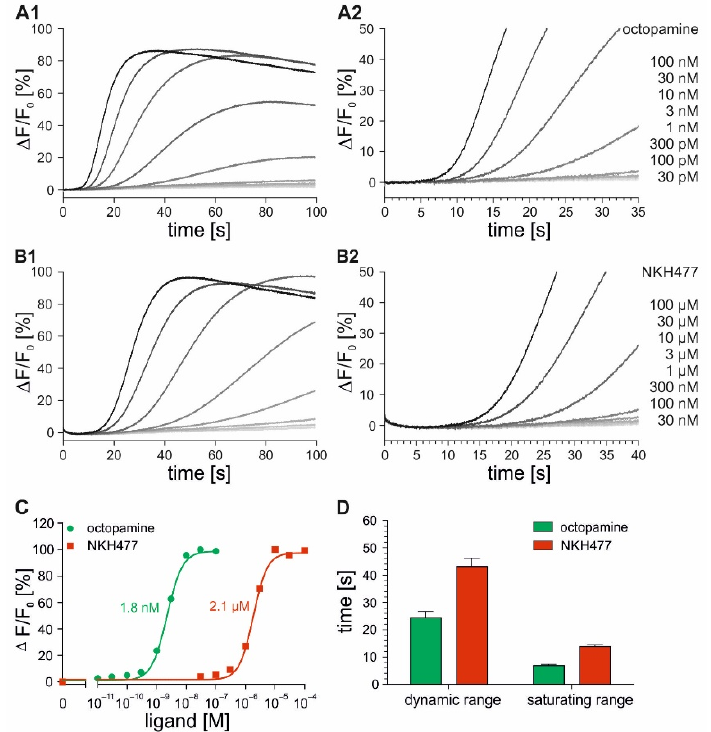
Figure 5. Stopped-flow experiments with FlpTM-DmOct β 1-GCaMP3.0 cell lines. FlpTM-DmOct β 1-GCaMP3.0 cells were stimulated with increasing octopamine ( A ) and NKH477 ( B ) concentrations. Fluorescence intensities were monitored over 100 s. Fluorescence changes ( Δ F/F 0 ) for each octopamine and NKH477 concentration were calculated and plotted over time ( A1 , B2 ). To resolve signal response times, the initial 35 s and 40 s of each measurement are shown ( A2 , B2 ). Shown are representative measurements from three independent datasets. Each data point was obtained from triplicate measurements; ( C ) Concentration–response curves were generated by plotting maximal changes in fluorescence against octopamine (green) and NKH477 (red) concentrations. Maximal changes in fluorescence at the highest ligand concentrations were normalized to 100% and EC 50 values were obtained from nonlinear fitting of the data using GraphPad Prism v5.04. A representative concentration–response curve from three independent datasets is shown. Mean EC 50 values are indicated; ( D ) Bar graph showing the time until signal was detected at concentrations in the range of EC 50 values (dynamic range) and at saturating concentrations (saturating range) for octopamine (green) and for NKH477 (red). Each data point was obtained from triplicate measurements. Shown are mean values ± SEM from three independent datasets.